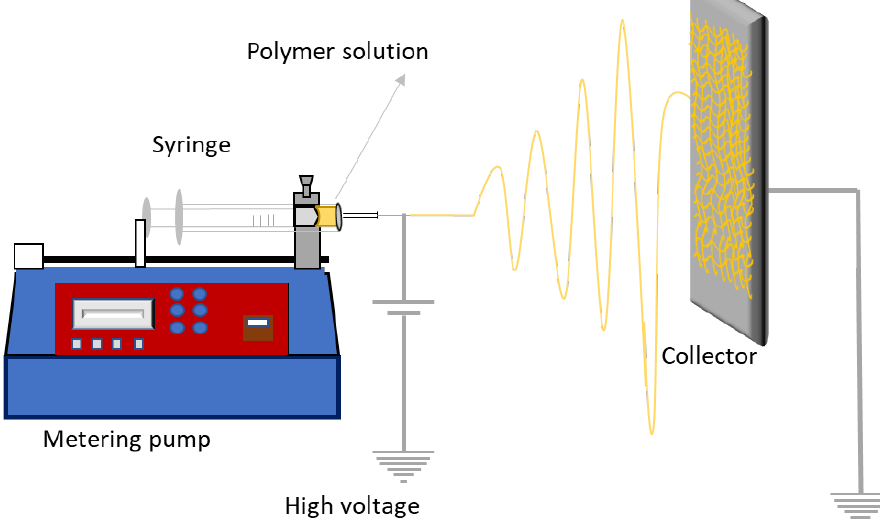
Figure 10. Basic configuration of electrospinning equipment (adapted from [171]).